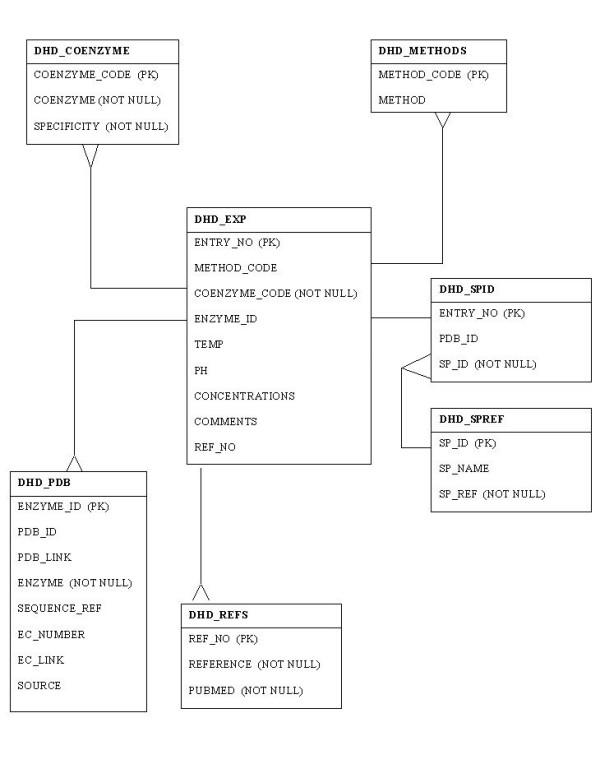
DSD Table Schema.